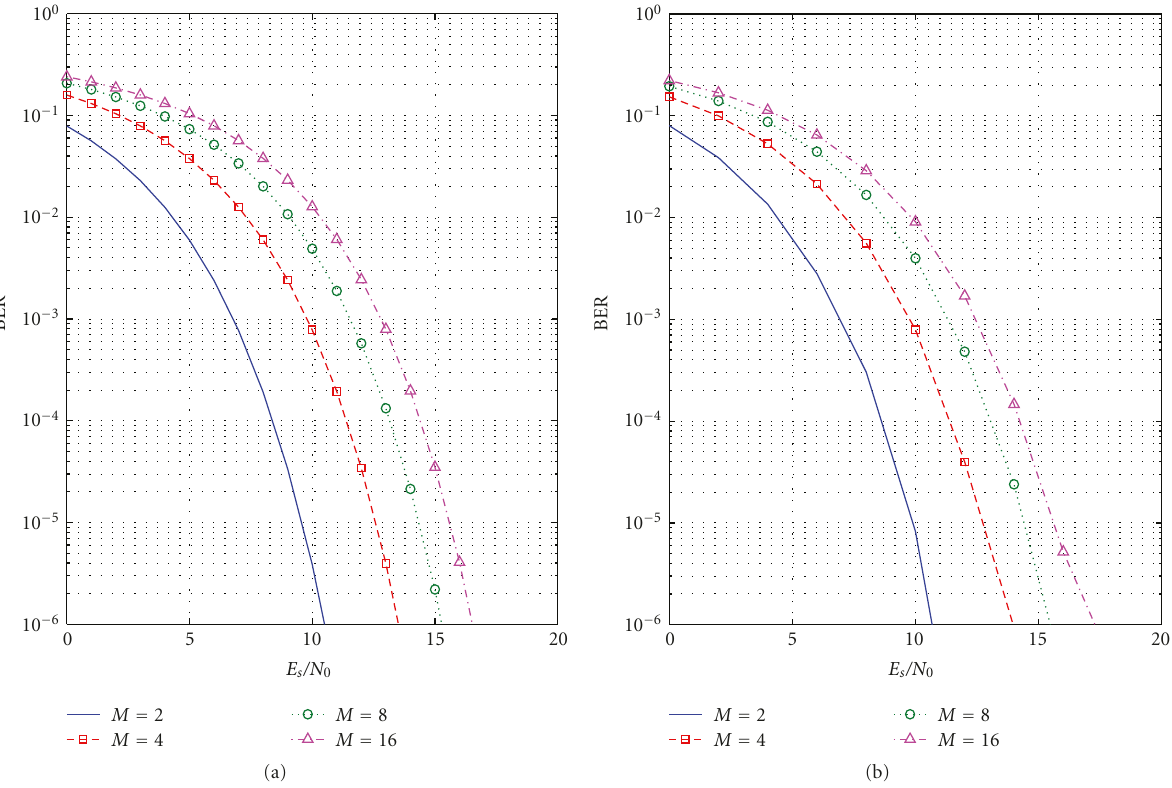
Figure 9: BER performance of the new modulation scheme for di ff erent modulation orders. (a) Theoretical curves (b) simulated curves with a shift step of 0.02 T sig